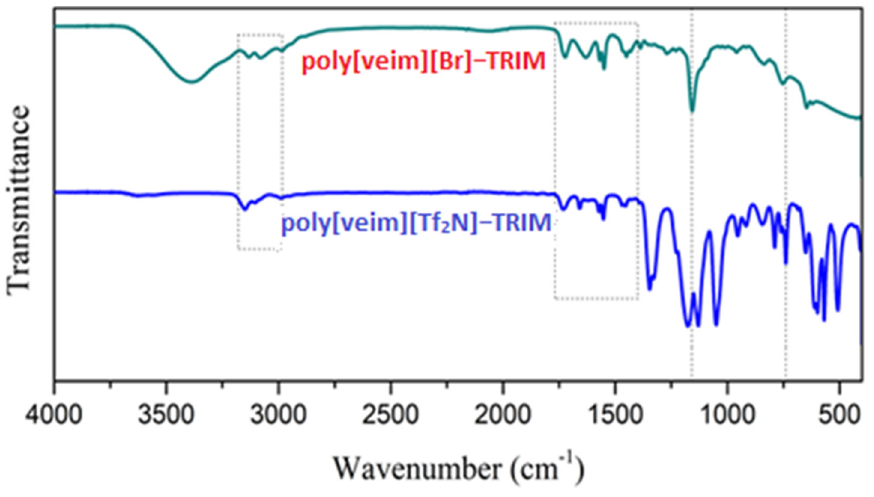
Figure 3. FT − IR spectra of poly[veim][Br] − TRIM and poly[veim][Tf 2 N] − TRIM adsorbents. The surface morphology of the synthesized polymers viz., poly[veim][Br]-TRIM and poly[veim][Tf 2 N]-TRIM, was examined with the aid of FE-SEM. The morphology